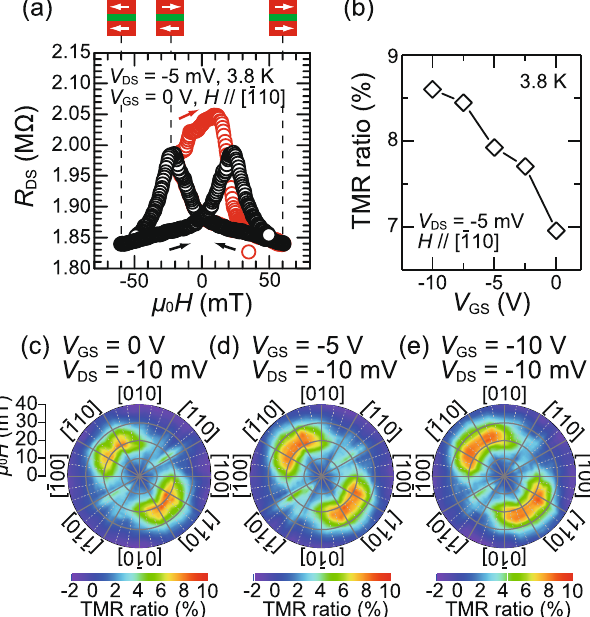
Figure 3. ( a ) Drain-source resistance R DS as a function of the in-plane external magnetic field μ 0 H applied along the [ 1 10] direction at 3.8 K. Here, the drain-source voltage V DS was − 5 mV and the gate-source voltage V GS was 0 V. The black circles correspond to the major loop and the red circles correspond to the minor loop. The black (red) arrows are the sweep directions in the major (minor) loop. The magnetization states in the major loop are indicated by the white arrows above the graph. ( b ) TMR ratio as a function of the gate-source voltage V V GS . ( c – e ) Magnetic-field-direction dependences of the TMR ratios at V DS = − 10 mV with V GS = 0 V ( c ), − 5 V ( d ) and − 10 V ( e